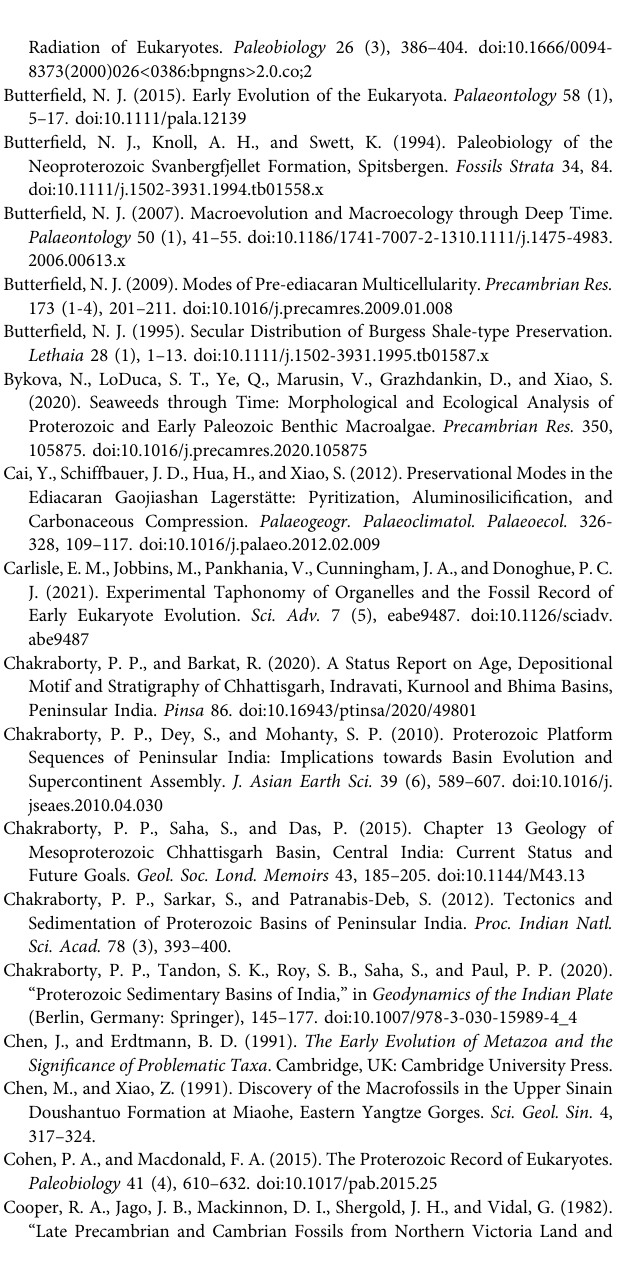
Supplementary Figure S3 | Raman spectra of organic matter of Saraipali fossiliferous shale extracted from HF maceration. Organic matter shows a distinct D- (1344 cm -1 ) and G- (1607 cm -1 ) band of organic carbon. Supplementary Figure S4 | 1 – 2. Large fossiliferous specimens from the Saraipali Shale showing both large carbonaceous fi lms and fragments on the bedding plane. Scale bar: 2.0 mm. 1. Specimen no. BSIP 42034; 2. Specimen no. BSIP 42045b. Supplementary Figure S5 | 1 – 2. Large fossiliferous specimens from the Saraipali Shale showing both large carbonaceous fi lms and fragments on the bedding plane. Scale bar: 2.0 mm. 1. Specimen no. BSIP 42045c; 2. Specimen no. BSIP 42045d. Supplementary Figure S6 | 1 – 2. Fossiliferous slab from the Saraipali Formation showing the repeated morphology of carbonaceous fi lms on the bedding plane. 1. Specimen no. BSIP 42045e; 2. Specimen no. BSIP